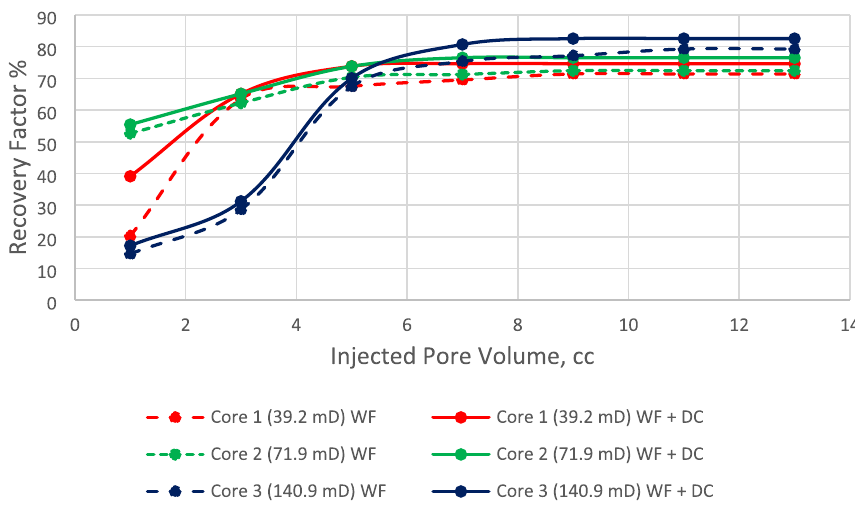
Fig. 10 Light oil recovery factor plotted against pore volume injected at constant potential gradient (adapted from